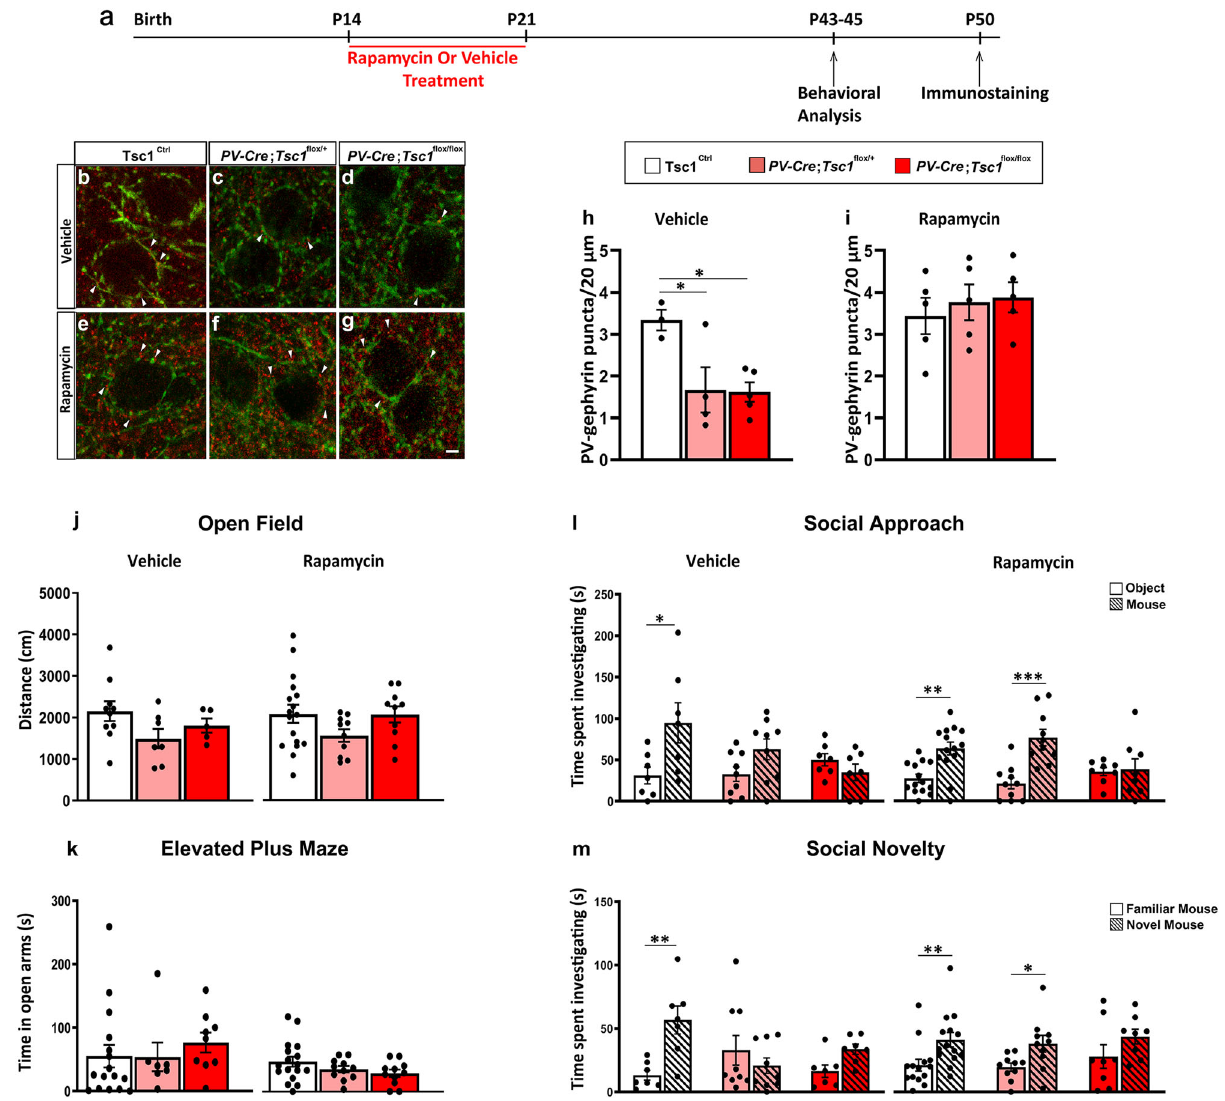
Fig. 10 Short term rapamycin treatment rescues loss of PV cell connectivity and social behavior de fi cits in adult heterozygous mutant mice. a Schematic for treatment paradigm. b – g Representative immunostained sections of somatosensory cortex labeled for PV (green) and gephyrin (red) in Vehicle ( b – d ) and Rapamycin ( e – g ) treated mice showing PV-Gephyrin colocalized boutons (arrowheads). h PV-Gephyrin colocalized puncta in